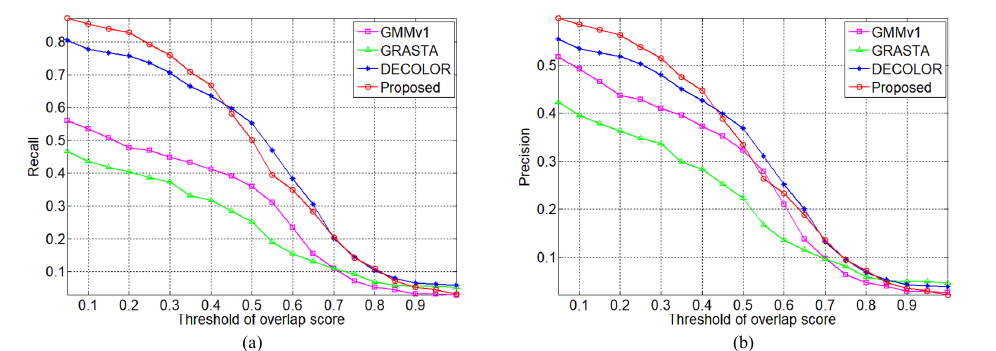
Figure 7. Curves of recall and precision with different threshold of overlap scores for flying small target detection on infrared image sequence ( a ) recall and ( b )